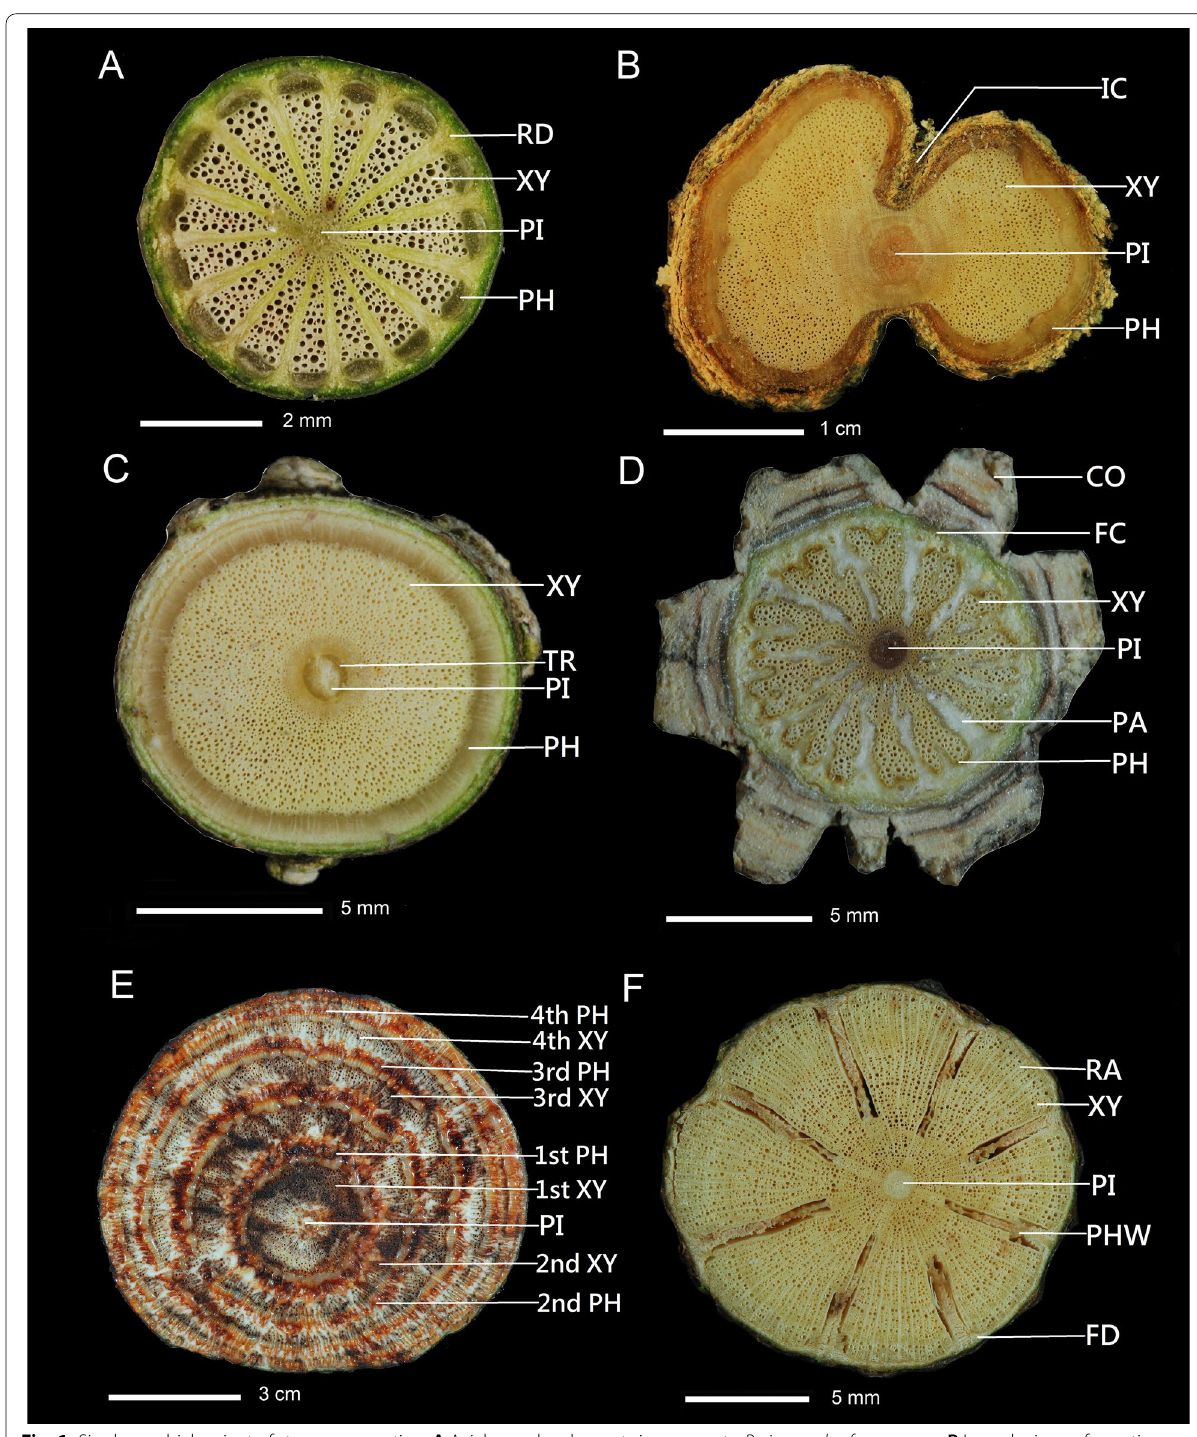
Fig. 1 Single cambial variant of stem cross section. A Axial vascular elements in segments: Pericampylus formosanus. B Irregular in conformation: Jasminum lanceolarium . C Intraxylary phloem: Melodinus angustifolius . D Furrowed xylem of cambium continuity: Morinda parvifolia . E Successive cambia: Mucuna macrocarpa . F Furrowed xylem of cambium discontinuity: Pyrostegia venusta . RD, ray dilatation, PI, pith, XY, xylem, PH, phloem, IC, irregular conformation, TR, intraxylary phloem, CO, cork, FC, furrowed xylem of cambium continuity, PA, parenchyma, 1st XY, first xylem, 2nd XP, second xylem, 3rd XP, third xylem, 4th XY, forth xylem, 1st PH, first phloem, 2nd PH, second phloem, 3rd PH, third phloem, 4th PH, forth phloem, FD, furrowed xylem of cambium discontinuity, PHW, phloem